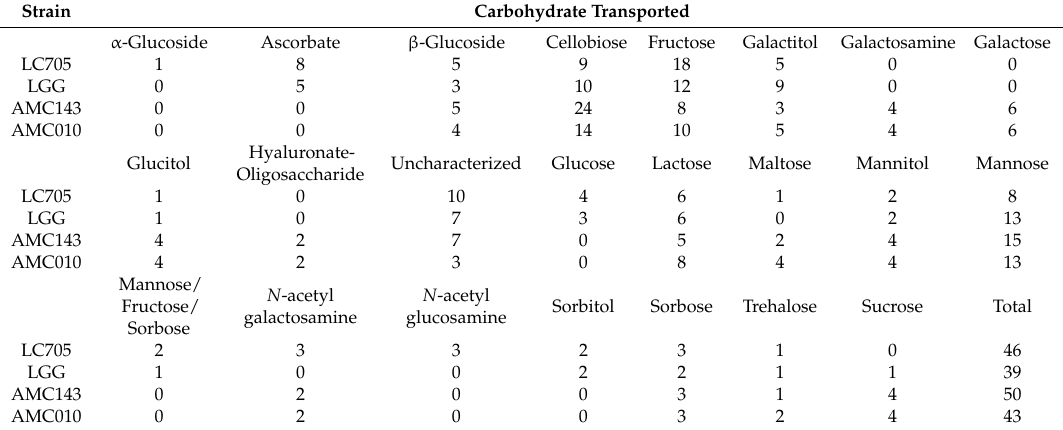
Table 2. Quantification and qualification of annotated phosphotransferase system (PTS) transporters in L. rhamnosus strains. Open Reading Frames (ORF) numbers for each gene can be found in Table